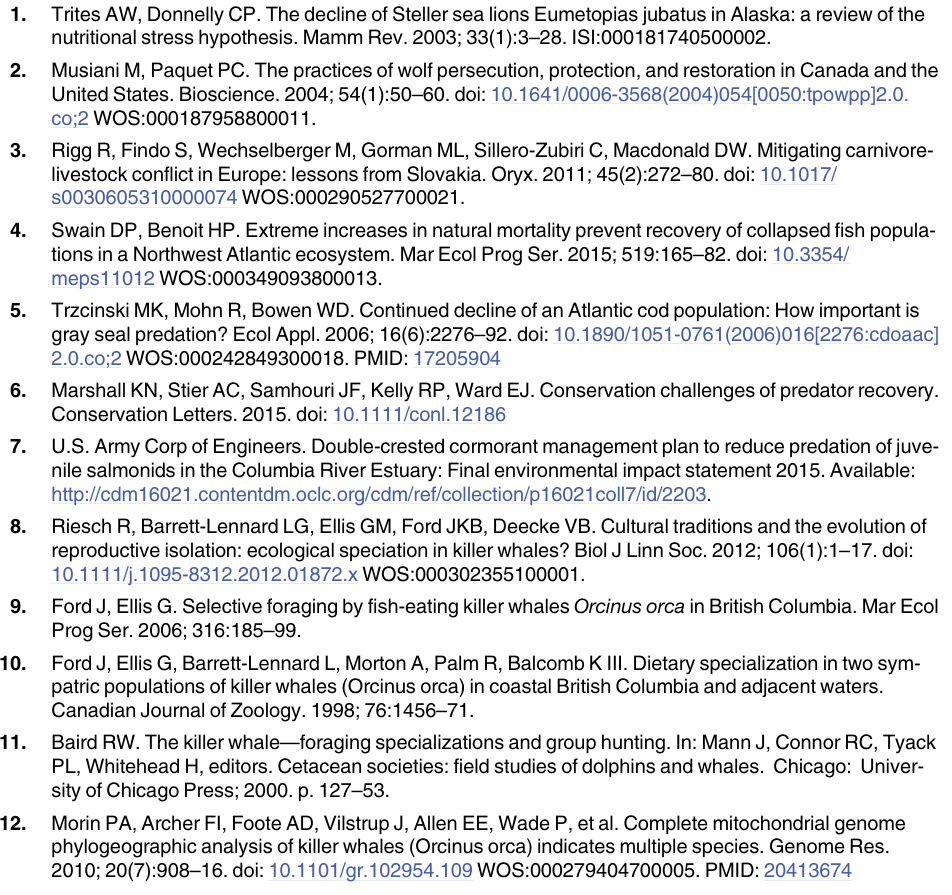
S4 Table. BLAST results of Pacific salmon 16s sequences from GenBank against our base-